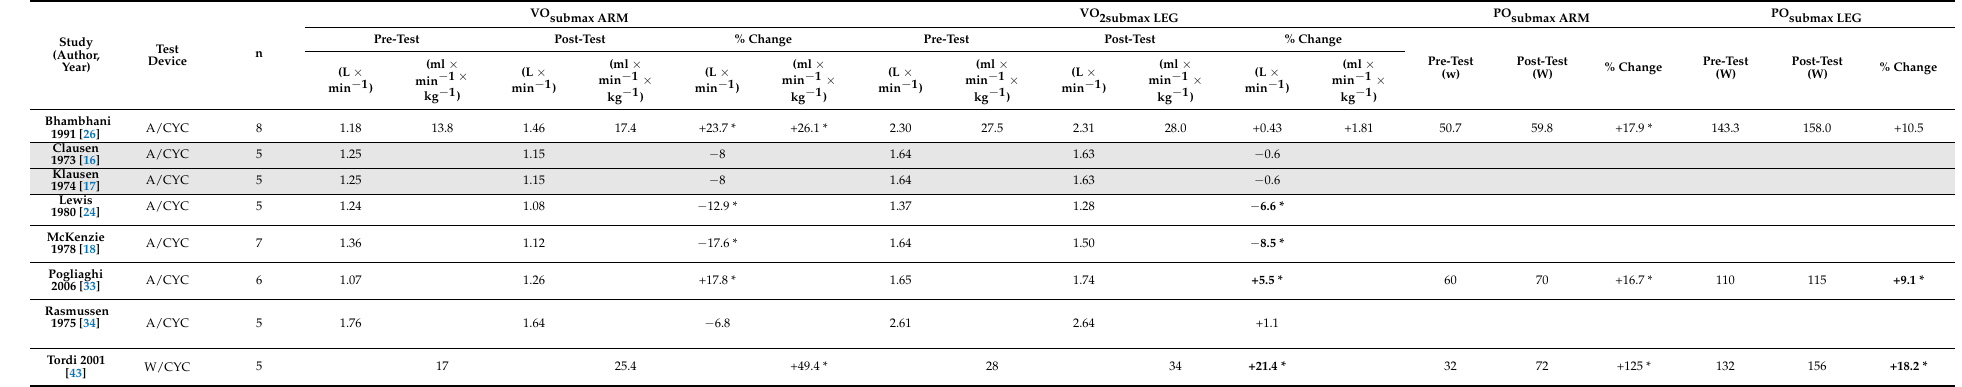
Table 7. Transfer effects on VO submax and PO submax from arm training to